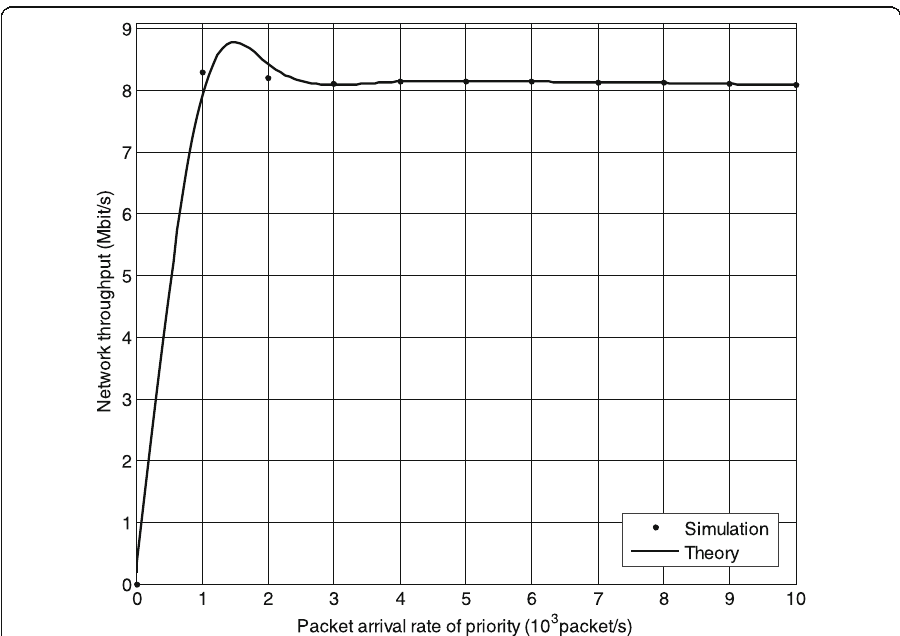
Fig. 7 Network throughput of the backoff mechanism in MCLA